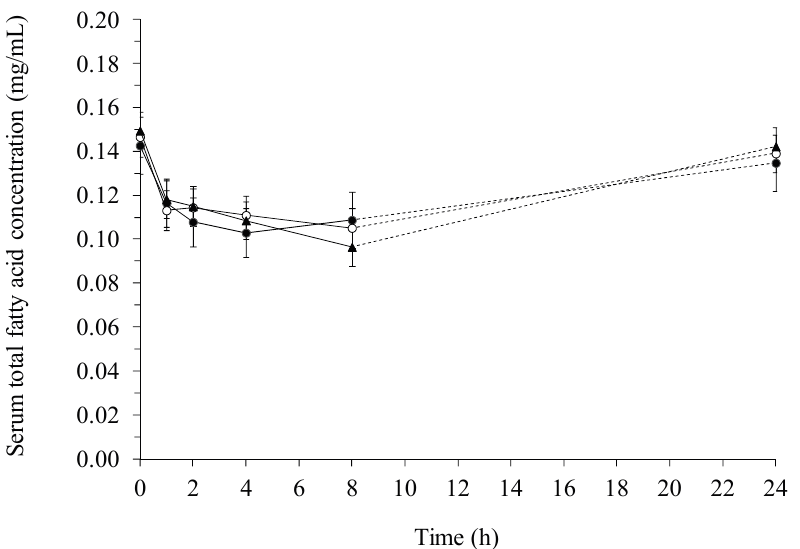
Figure 4. Total fatty acid concentration (mg/mL) in serum of pigs fed a β -glucan free basal diet ( ● ) or diets supplemented with either barley ( ○ ) or yeast ( ▲ ) β